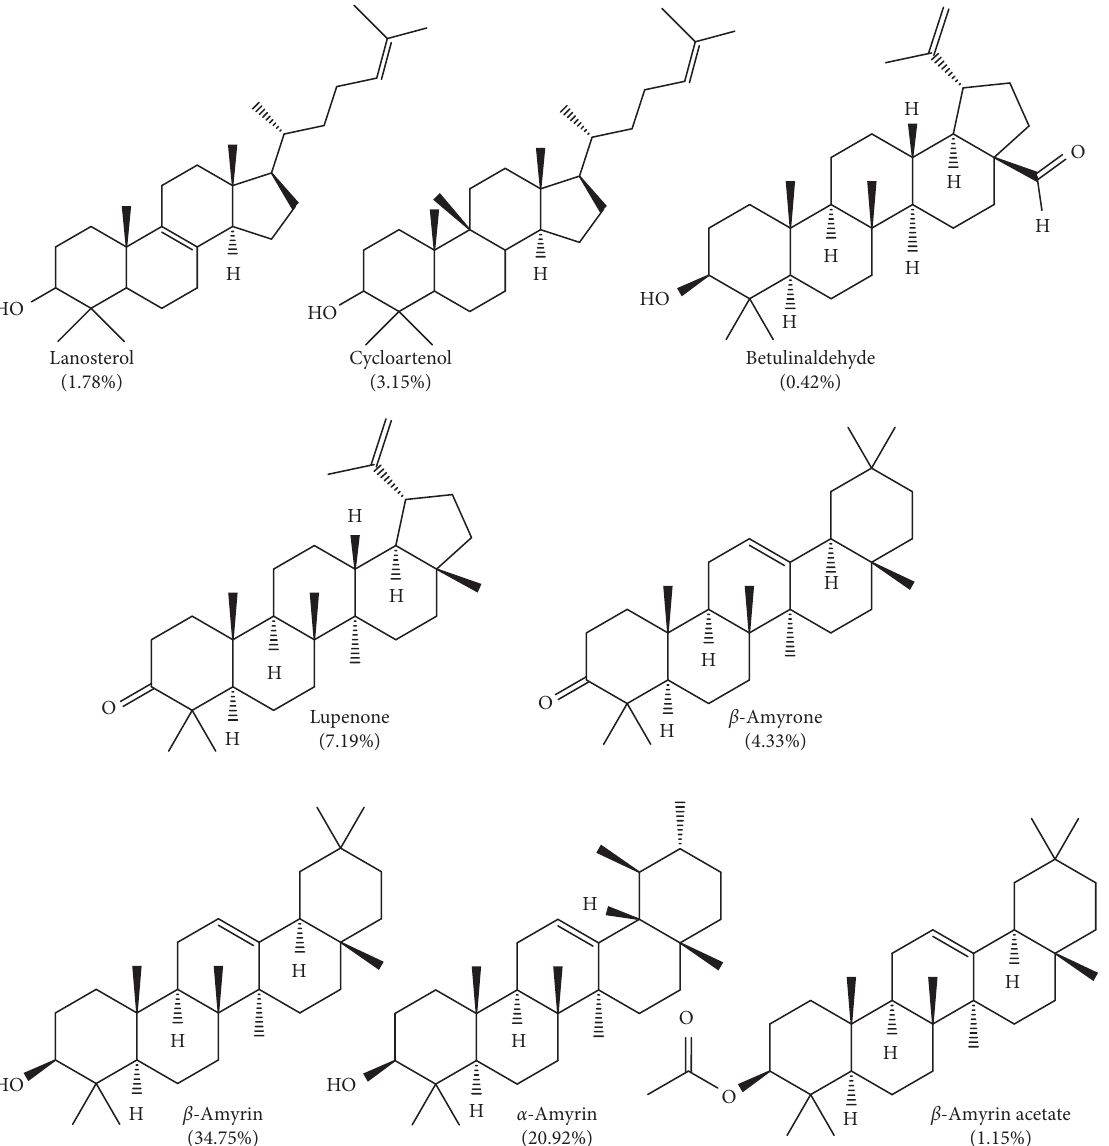
Figure 3: Structures of cyclic triterpenoids identifed in the saponifed diethyl ether extract of pili pulp oil. Values in parenthesis denote relative abundance in percent of total ion